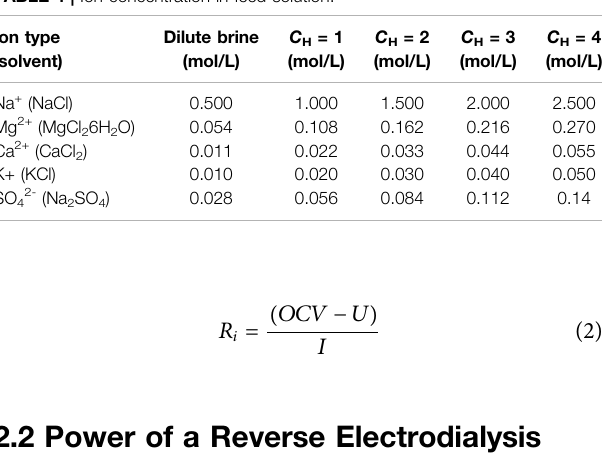
TABLE 1 | Main instruments.